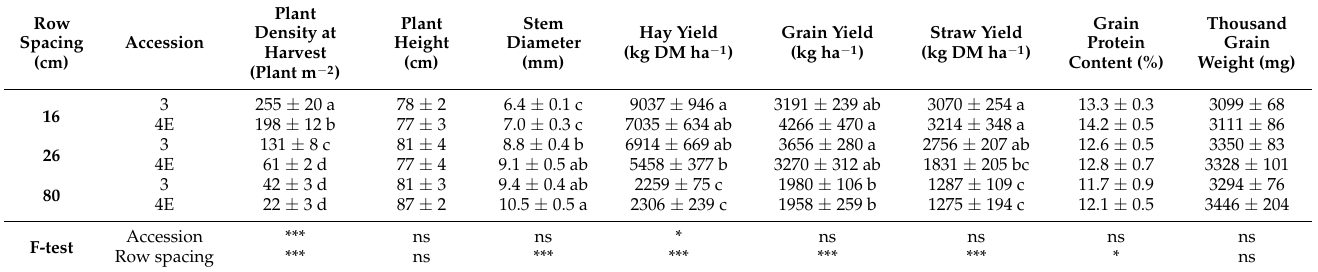
Table 2. Row spacing, plant density at harvest, yields, growth, and grain-quality parameters of quinoa accessions 3 and 4E sown in November 2018. Results are presented as mean value ± standard error.